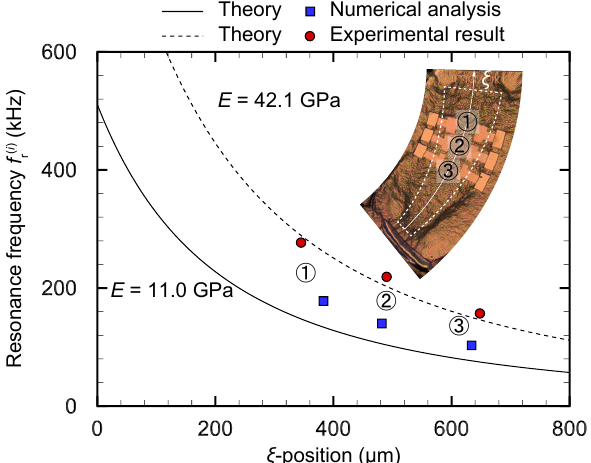
Figure 11. Comparisons of resonance frequencies obtained from theoretical, numerical, and experi- mental results in a miniaturized artificial cochlear sensory epithelium for in vivo testing. Because the resonance frequencies may be mainly determined by the oscillation of the η -axis, theoretical values are calculated using Euler–Bernoulli beams. Although there is a maximum deviation of 33.8% between theory and numerical calculation and of 56.4% between the experimental and numerical results, the frequency selectivity performance has been evaluated. We believe that Young’s modulus is the main cause of the deviation, and it is necessary to evaluate the physical properties of thin films on a micrometer